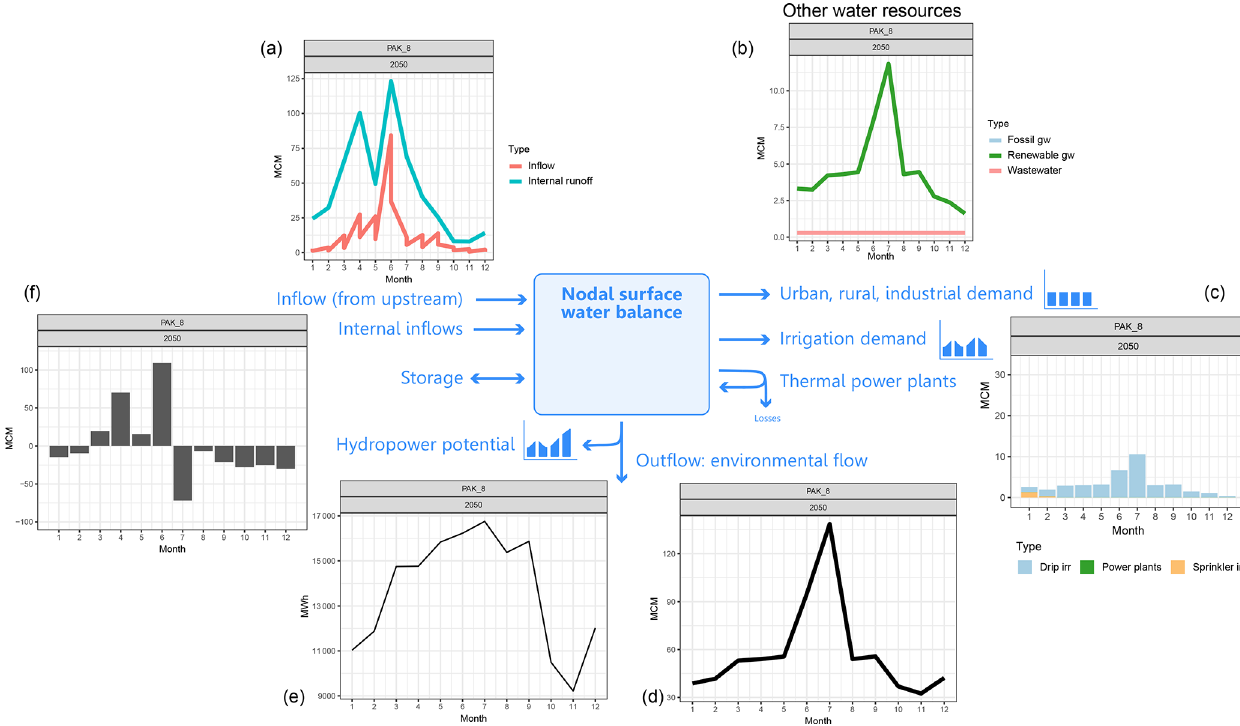
Figure 9. Surface water balance for a specific BCU (PAK_8) in 2050: (a) surface water inflows; (b) supply from other water sources; (c) variable water demand; (d) surface water outflow; (e) hydroelectric generation; (f) storage-level changes: recharging if positive, discharging if negative.